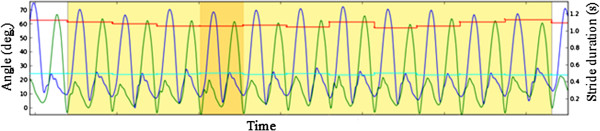
Typical knee angle profile obtained during the test procedure. The darker shaded area shows the most typical stride during the test, which is used for subsequent analysis.